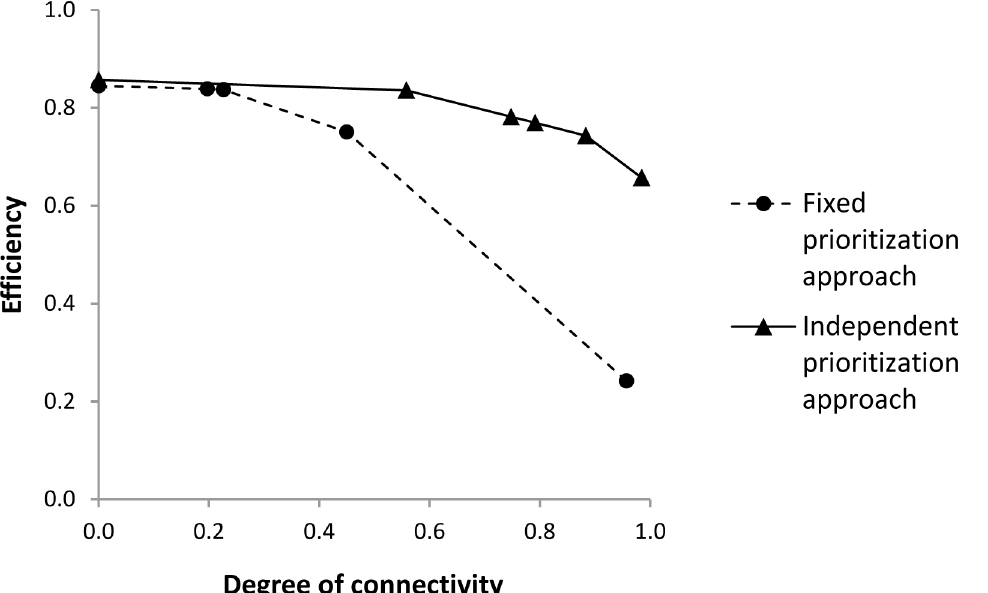
Fig 5. Efficiency of the best solution for increasing degrees of connectivity achieved in the best solution, and for different prioritization approaches. Efficiency is a measure of the ratio between the cost of the selected actions and the cost of all potential actions. The degree of connectivity is calculated as one minus the ratio of the connectivity penalty of the best solution, for a specific value of BLM (Fixed approach), or CSM (Independent approach), and the highest connectivity penalty among the best solutions for all values of BLM , or CSM . Dots represent the fixed prioritization approach, while triangles represent the independent prioritization